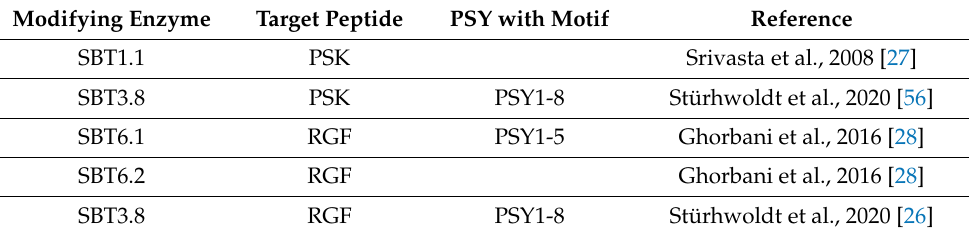
Table 3. Enzymes involved in processing of tyrosine sulfated peptides. Abbreviations: subtilisin- like serine protease (SBT), phytosulfokine (PSK), root meristem growth factor (RGF), plant peptide containing tyrosine sulfation